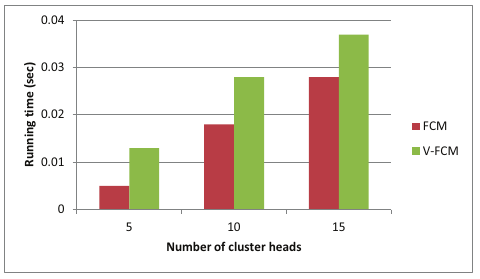
Fig :6 Running time VS No of clustering head Number of received data in sink node by varying the number of the sensor nodes